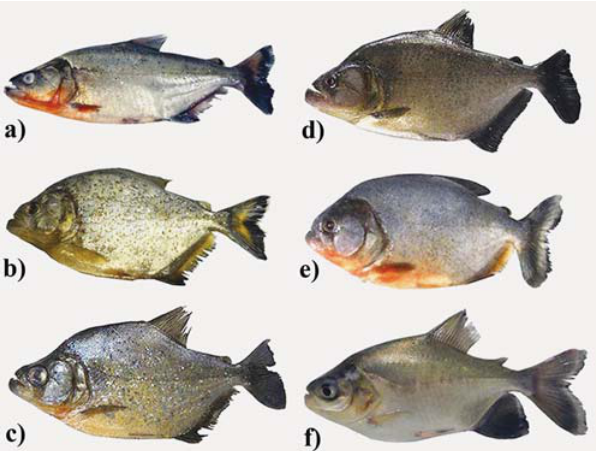
Fig. 1. Analyzed Serrasalmidae species: a ) Serrasalmus elongatus (total length = 19.5 cm); b ) Serrasalmus maculatus (total length = 15.5 cm); c ) Serrasalmus cf. rhombeus (total length = 12.5 cm); d ) Serrasalmus rhombeus (total length = 17.5 cm); e ) Pygocentrus nattereri (total length = 15.0 cm); f ) Colossoma macropomum (total length = 19.0